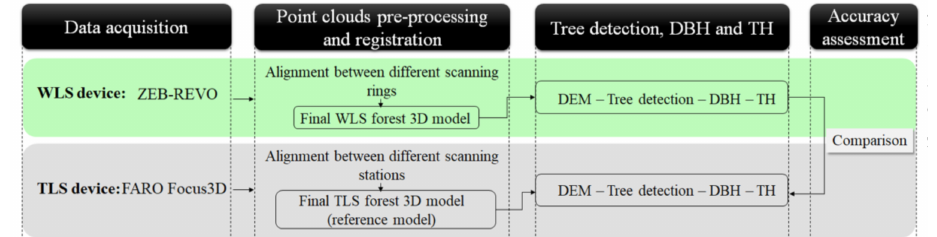
Figure 5. Workflow of the methodology proposed to assess the accuracy and suitability of the ZEB-REVO device for estimating forest variables.